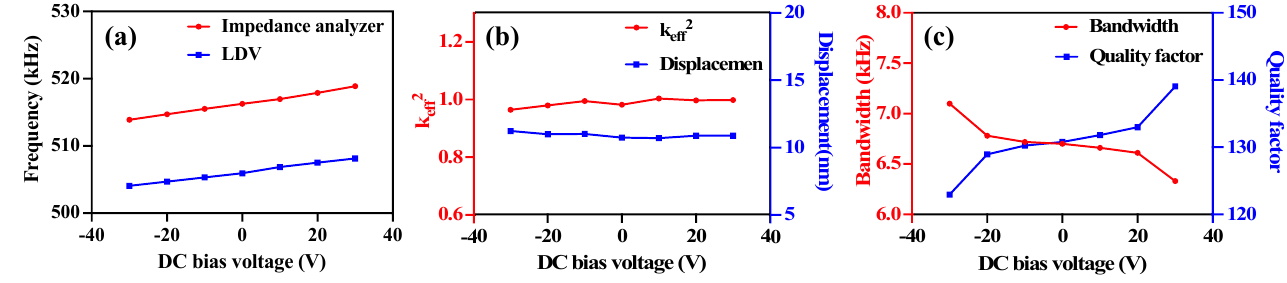
Figure 5. The DC bias effects on the performance of the PMUT: ( a ) the linear variation in frequency for estimating the effect of DC bias; ( b ) the effect of DC bias on 𝑘 𝑒𝑓𝑓2 and film displacement; ( c ) the dependency of the − 6 dB bandwidth and the 𝑄 on DC bias voltage.